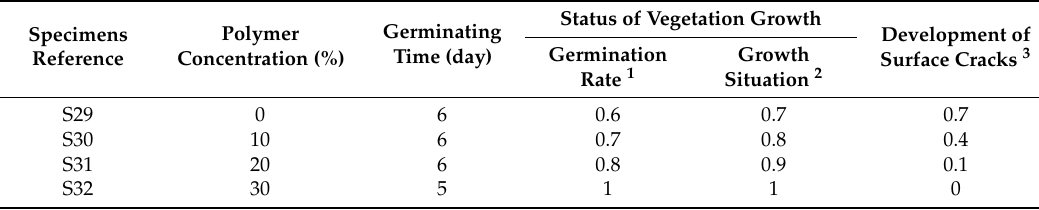
Table 5. The results of the seed growth